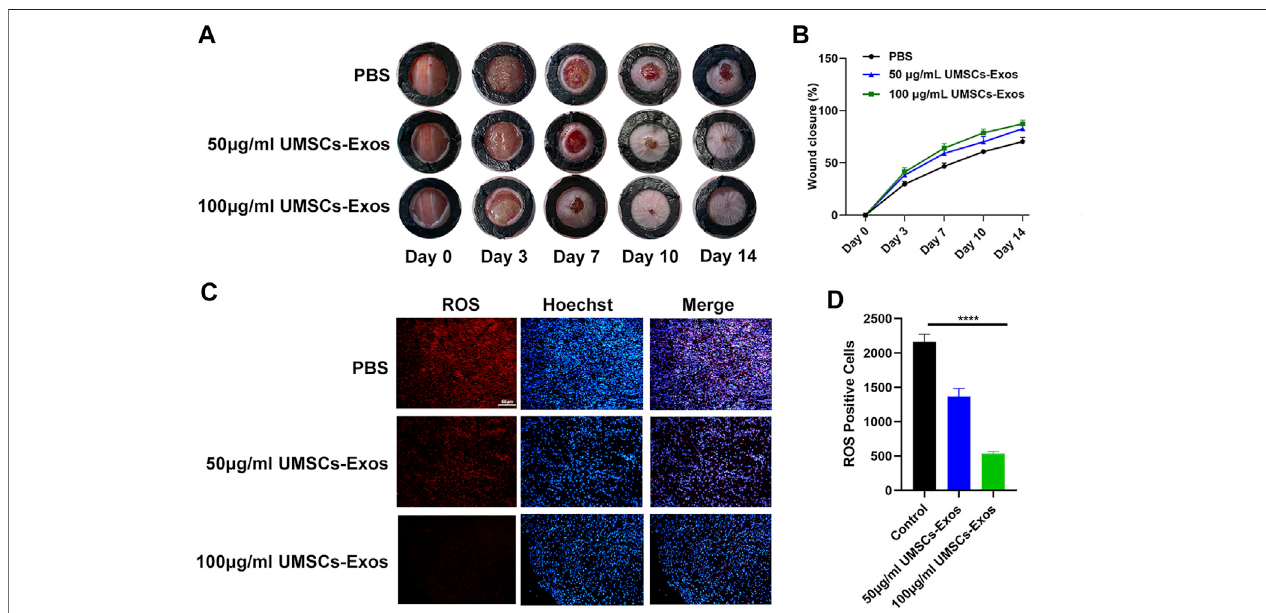
FIGURE 5 | HUC-Exos accelerate diabetic cutaneous wound healing in vivo . (A) Representative images of the wound healing process of mice treated with PBS, 50 μ g/ml ofUMSCs-Exos,and 100 μ g/ml ofUMSCs-Exos(n = 10). (B) Invivo wound closure ratesofthe fi ve groups at differenttimepoints. (C) ROS level assessed by immunohistochemistry (IHC) staining. (D) Fluorescence quanti fi cation ofthe wound length at day 14. Scalebar: 50 μ m. Differences were measured byone-wayANOVA followed by a Tukey post hoc test for pairwise comparison. Data presented as means ± SD. **** p < 0.0001, *** p < 0.001, ** p < 0.01, and * p < 0.05.